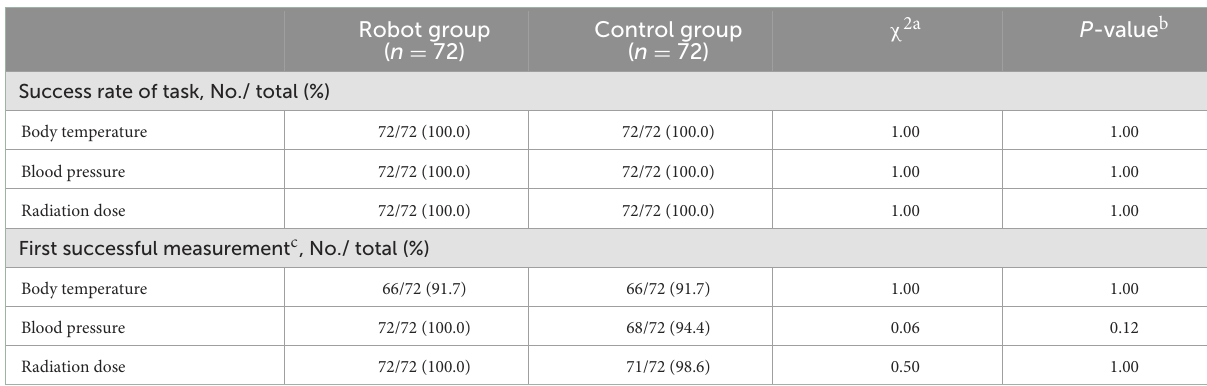
TABLE 2 Primary clinical outcome of effectiveness